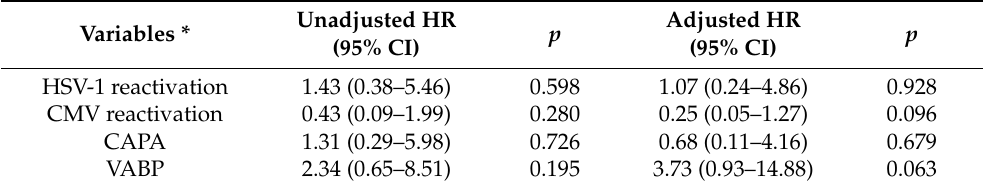
Table 3. Univariable and multivariable analyses of the potential impact on mortality of pulmonary infectious events in intubated COVID-19